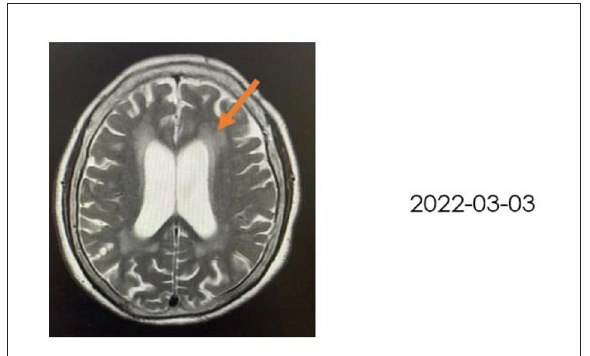
FIGURE2 Brain MRI took on 3 March 2022, revealing significantly reduced